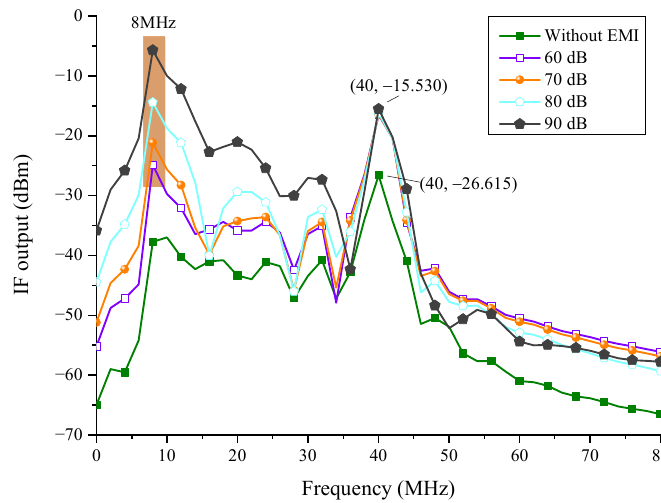
Figure 24. The injection interference law in node 5.